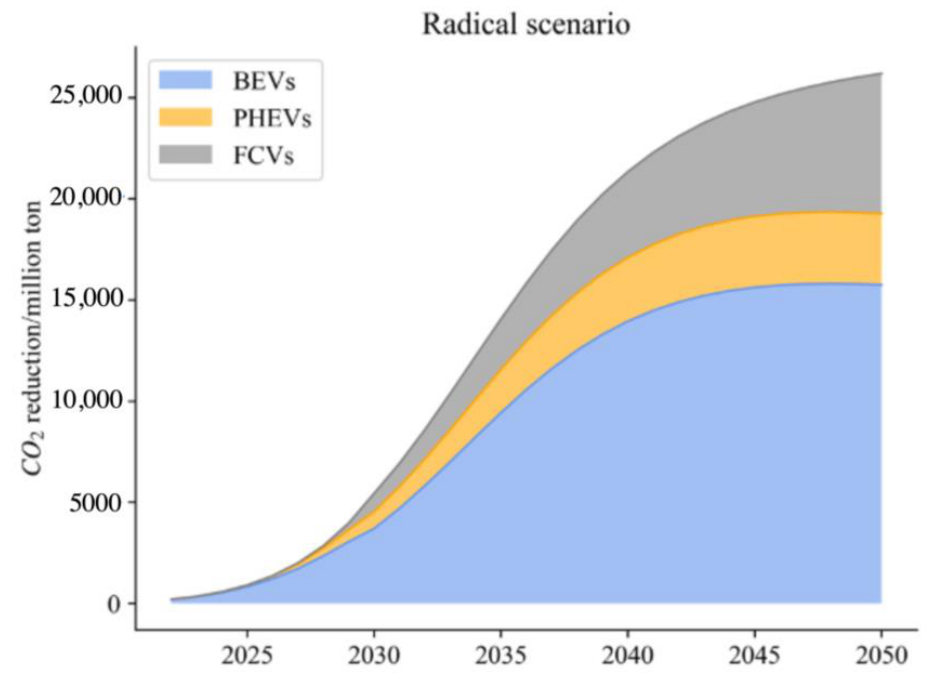
Figure 7. Carbon reduction under the radical scenario.